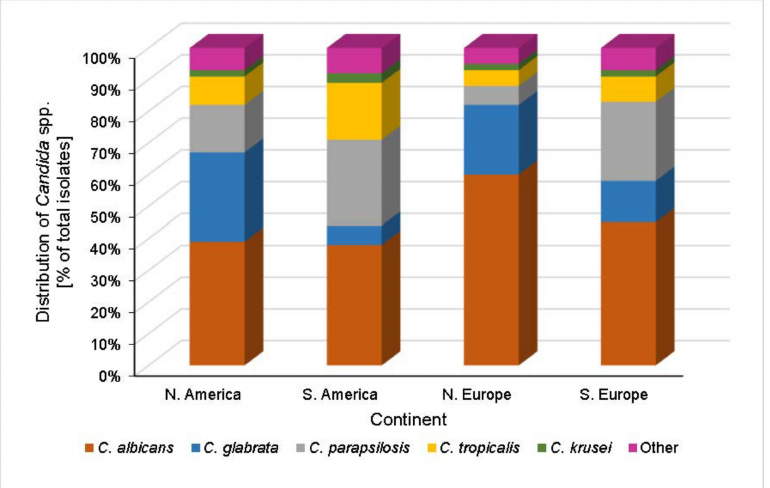
Figure 3. Distributions of Candida spp. as a percentage of total IC case counts across North America, South America, North Europe and South Europe [6,54,109–111]. In North America, C. albicans is the most prevalent Candida species, accounting for ~39% of IC episodes. The most common NAC species, representing just under 30% of cases, is C. glabrata with sequentially lower case contributions from C. parapsilosis, C. tropicalis and C. krusei. European IC species distribution shows two clear trends, split broadly between the north and south of the continent. Northern Europe typically exhibits a similar species distribution to North America, although a greater contribution from C. albicans is seen, accounting for 60% of cases. In contrast, the species landscape in southern Europe is more akin to that in South America, where C. parapsilosis is the most common NAC species. Across these four regions, <10% of total cases are attributed to species outside of the five